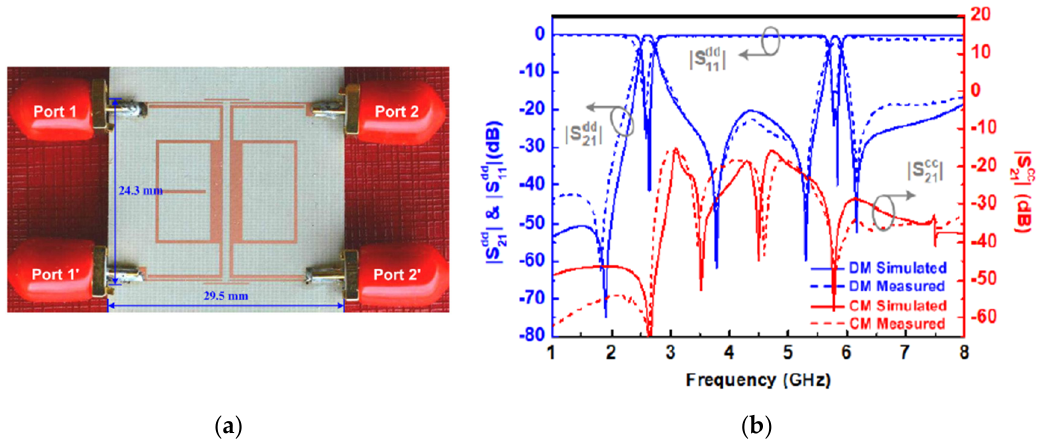
Figure 10. The proposed balanced dual-band BPF [66]: ( a ) Coupling scheme; ( b ) Photograph of the fabricated prototype; ( c ) Simulated external quality factors; ( d ) Simulated and measured frequency responses.